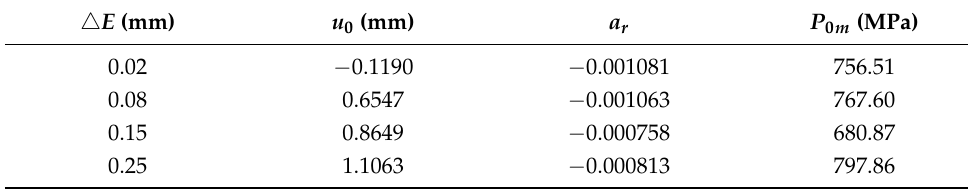
Figure 18. Contact paths of the modified helical face gears with different pinion-offset errors. As Table 12 indicates, as the axial displacement error △ q gradually increases from 0 to 0.08 mm, the optimal modification coefficient u 0 changes from 1.6406 mm to −0.7123 mm. Accordingly, the quadratic coefficient a r also changes from −0.001125 to −0.001086, and the optimized maximum contact stress is close to 758.36 MPa. As shown in Figure 17, the contact paths on the tooth surface of the face gear evidently move toward the middle area as the assembly error grows, which decreases the risks of edge contact. The points of the maximum contact stress on the gear surface do not change significantly and remain at the same tooth height. Thus, in actual installations, the displacement error △ q is recom- mended to be controlled within the range of 0.08 mm, and the contact performance of the modified face gear is relatively ideal. As shown in Table 13, the pinion offset △ E greatly influences the optimal modifica- tion coefficients and the contact stresses of the modified face gear drive. As the offset value grows from 0.02 mm to 0.25 mm, the optimum modification parameter u 0 correspondingly varies from −0.1190 mm to 1.1063 mm, and the coefficient a r also changes from −0.001081 to −0.000813, which results in the fluctuation of the maximum contact stresses. Figure 18 reveals that the gradual increase in the offset values causes the contact paths to move to the inner portion of the face gear and also causes the point of the maximum contact stress to move along the direction of tooth height. In other words, the addition of offset △ E in- creases the risks of edge contact. When the offset △ E is equal to 0.15 mm, the maximum contact stress is 680.87 MPa, which is the smallest in the given range. In this case, the contact path is reasonable. In summary, the recommended value of the offset error △ E is 0.15 mm, taking into account the inevitability of assembly errors.